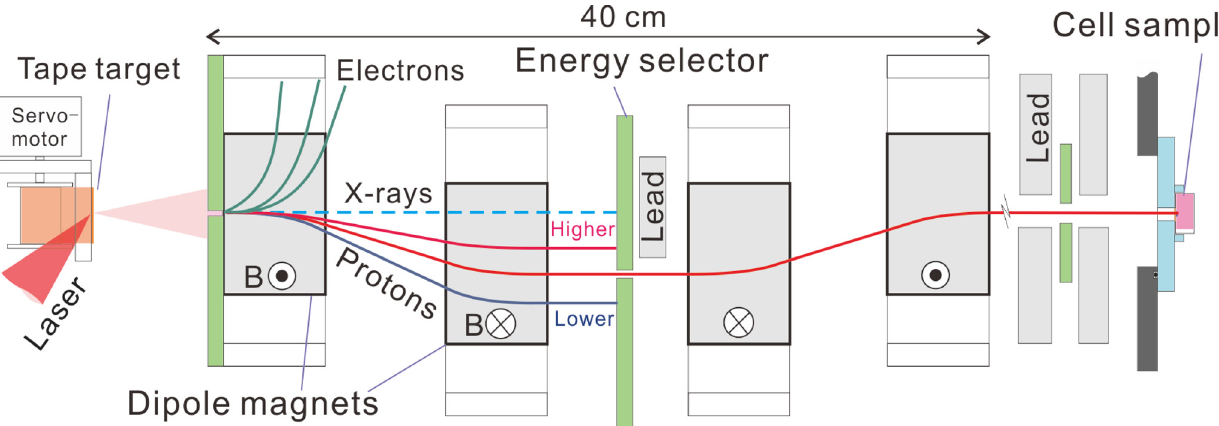
Figure 20. Experimental setup of the laser-driven quasi-monoenrgetic beam line